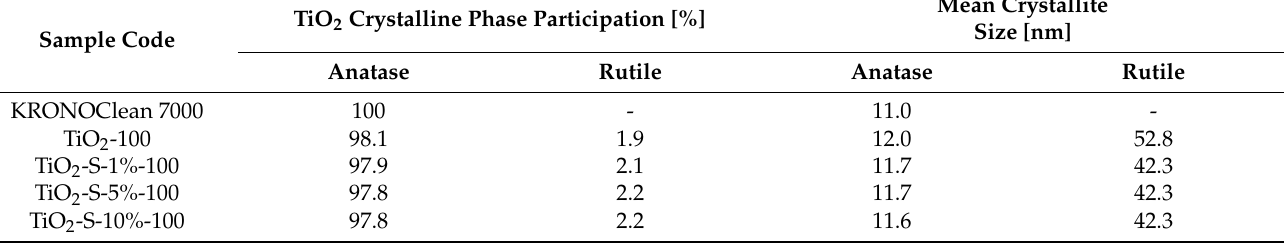
Table 1. The phase compositions and average crystallite sizes of the reference KRONOClean 7000, starting TiO 2 -100 and carbon-modified photocatalysts.